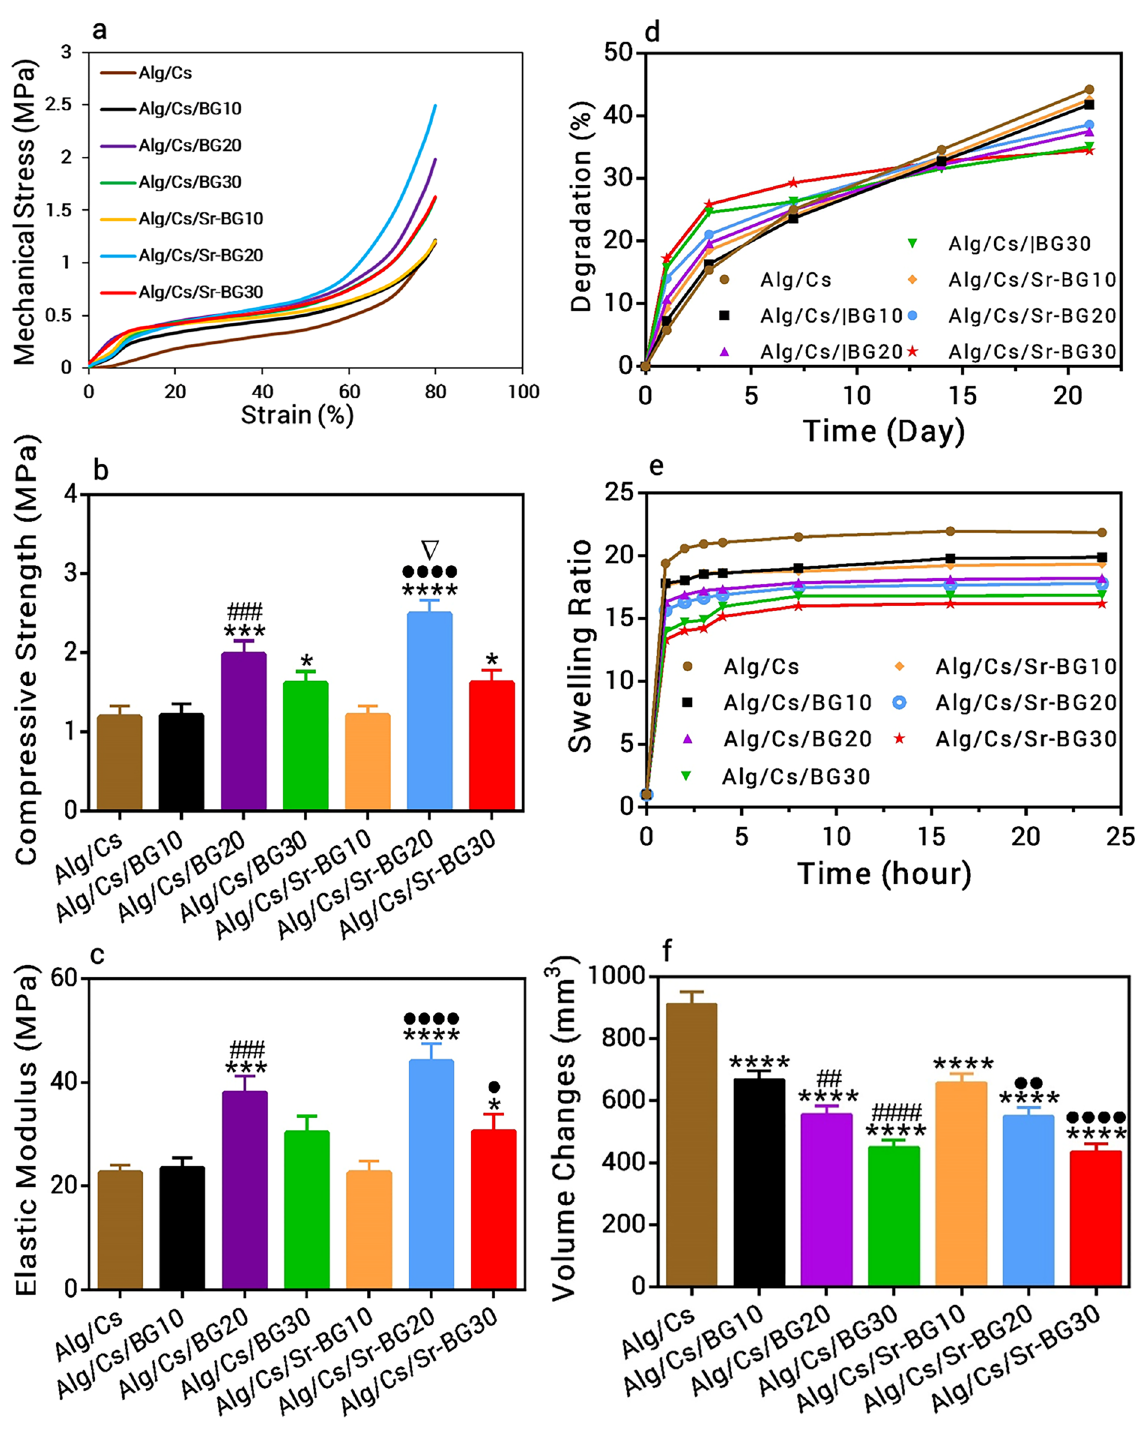
Figure 6. Mechanical test, degradation and swelling profile of scaffolds. ( a ) Stress–strain curve, ( b ) Compressive strength, ( c ) Elastic Modules, ( d ) Degradation profile, ( e ) Swelling profile and ( f ) Volume changes during swelling. Significant difference with Alg/Cs group at p < 0.05 (*), p < 0.001 (***), p < 0.0001 (****). Significant difference with Alg/Cs/BG10 group at p < 0.01 ( ## ), p < 0.001 ( ### ), p < 0.0001 ( ####) . Significant difference with Alg/Cs/Sr-BG10 group at p < 0.05 ( · ), p < 0.01 ( ·· ), p < 0.0001 ( ···· ). Significant difference between Alg/Cs/BG and Alg/Cs/Sr-BG groups at p < 0.05 ( ⛛